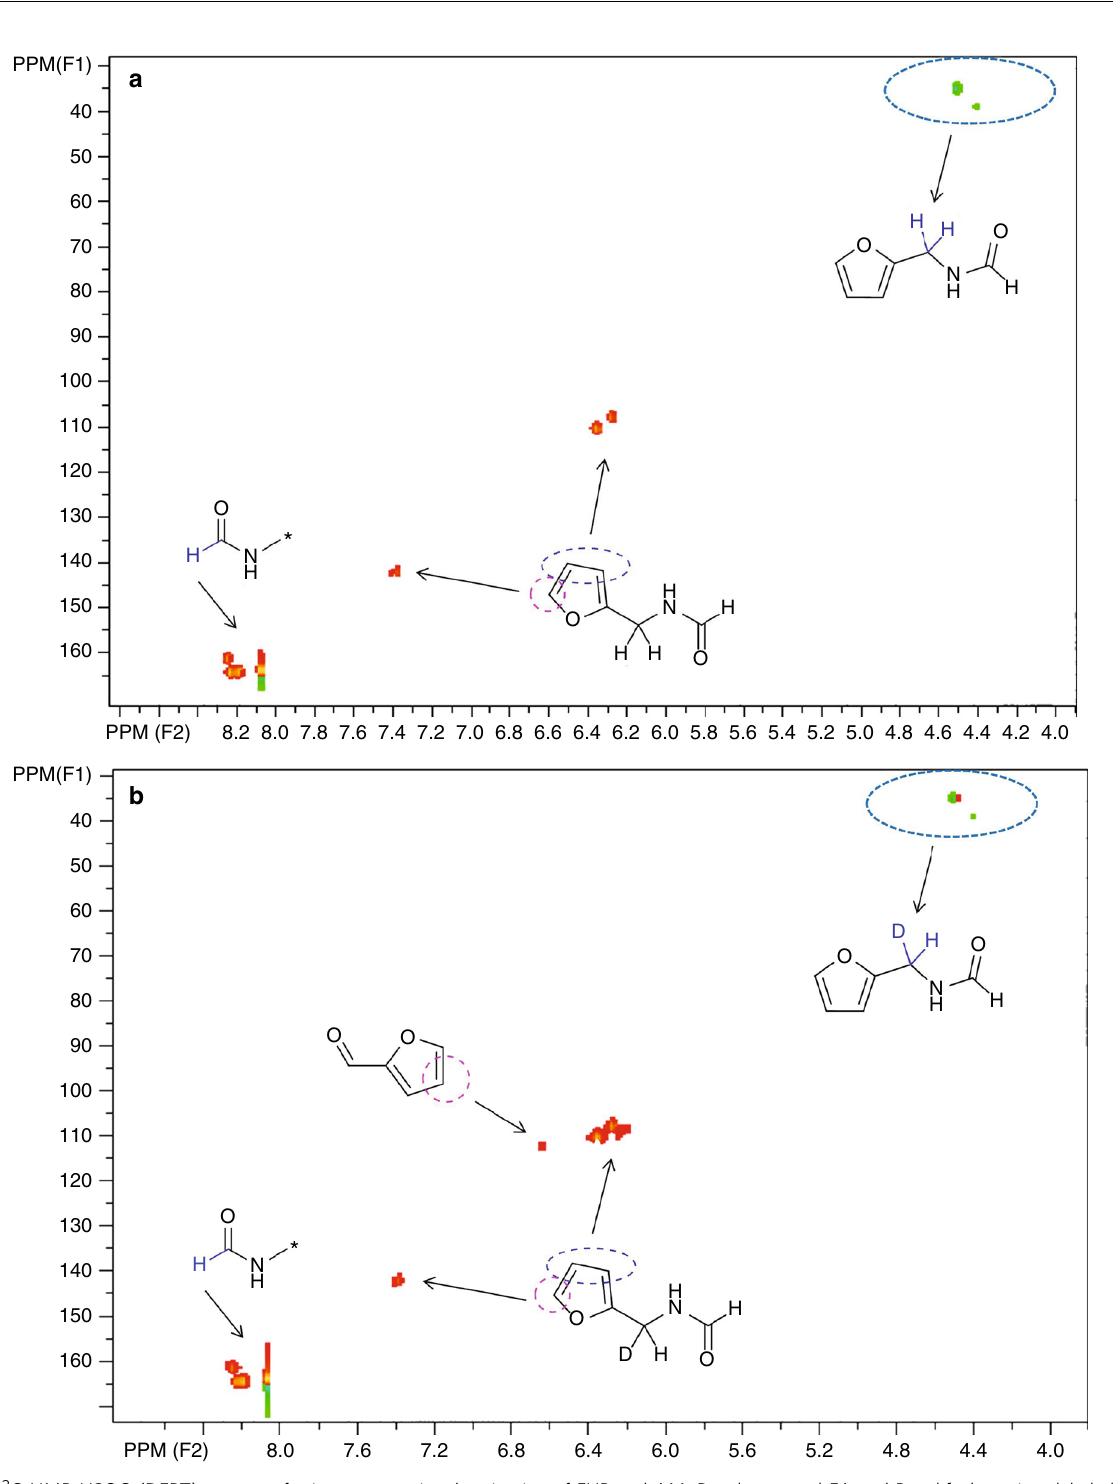
Fig. 3 1 H- 13 C NMR HSQC (DEPT) spectra of microwave-assisted amination of FUR and AM. Panel a normal FA and Panel b deuterium-labeled FA (red color: CH or CH 3 , green color: CH 2 ); Reaction conditions: 2 mmol FUR, 6 mmol FA, 12 mmol AM, 180 °C, 3